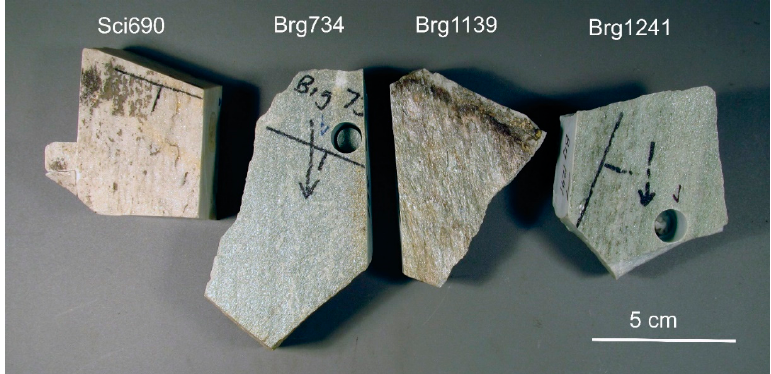
Figure 2. Four typical hand specimens of Triassic quartzites. They display an excellent foliation and the lineation on the schistosity plane. Scale is indicated. In samples Brg734 and Brg1241 there is a cylindrical hole from which the neutron diffraction samples were obtained.